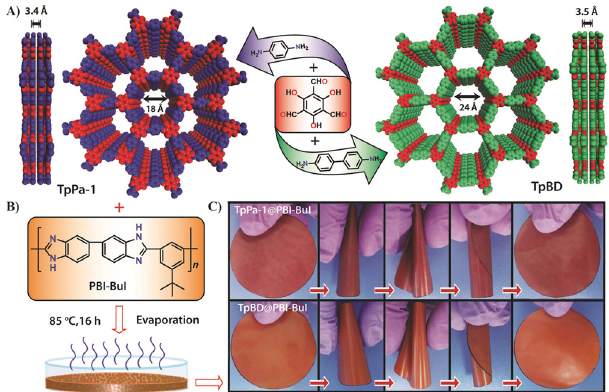
Figure 18. ( A ) Schematic representations of the synthesis of COFs and their packing models indicating the pore aperture and stacking distances. ( B ) Overview of the solution-casting method for COF@PBI-BuI hybrid membrane fabrication. ( C ) Digital photographs showing the flexibility of TpPa-1 and TpBD(50)@PBI-BuI hybrid membranes. Reprinted with permission from [141], Copyright (2016) John Wiley and Sons publications.